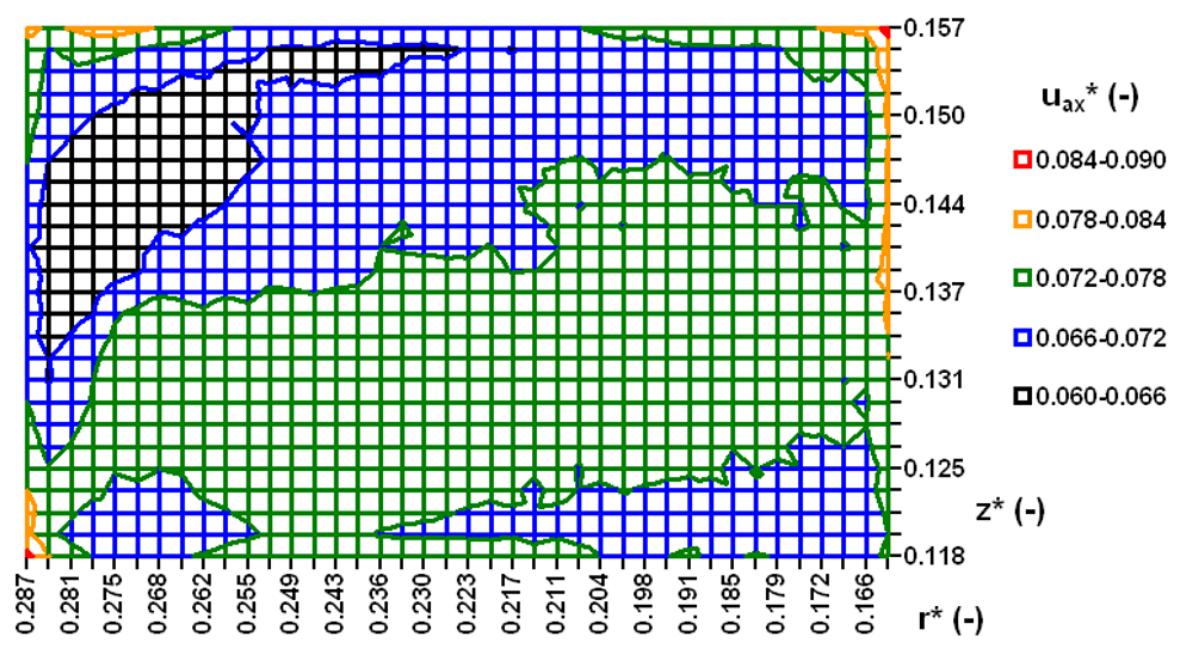
Fig. 5. Dimensionless axial fluctuation velocity distribution u ax* = ) / ( N D u